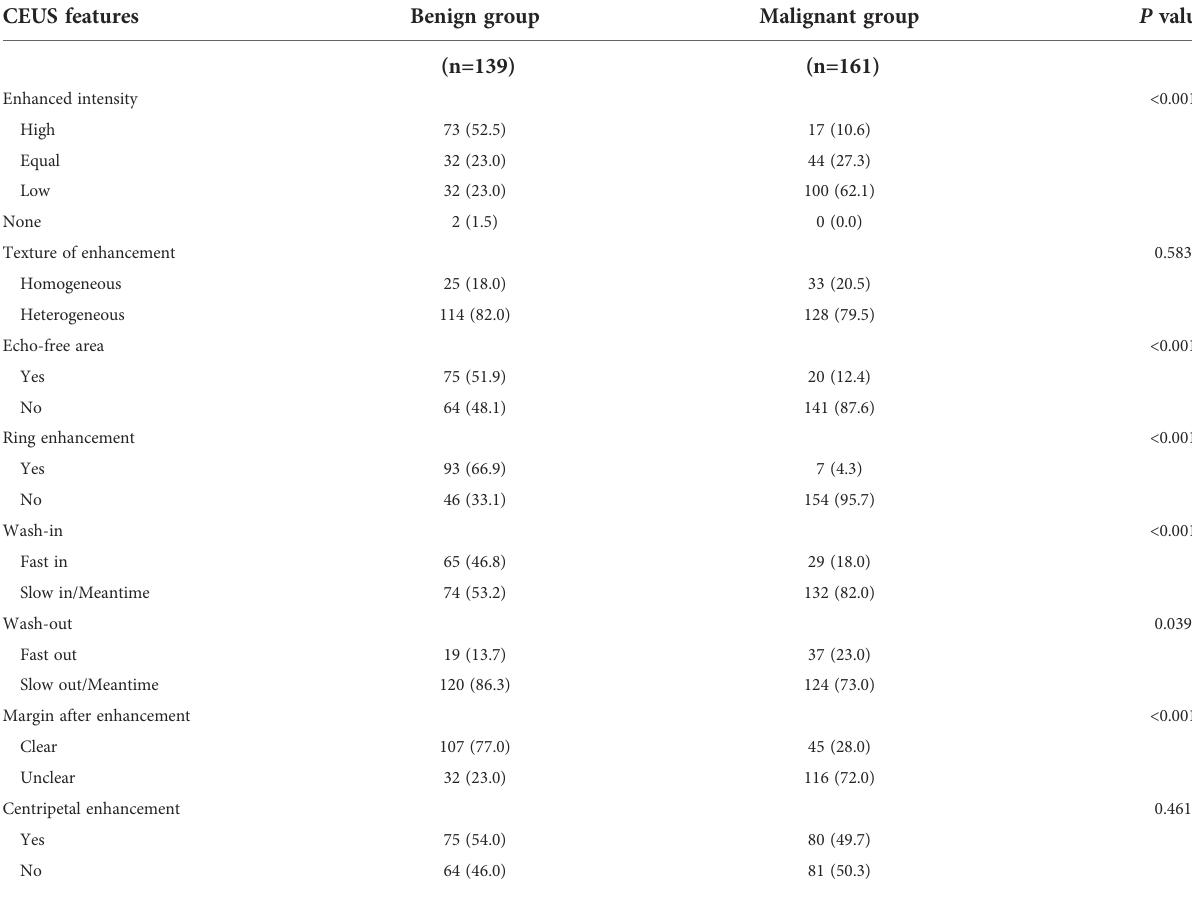
TABLE 4 Contrast-enhanced ultrasound (CEUS) features of benign and malignant thyroid nodules in the training set.